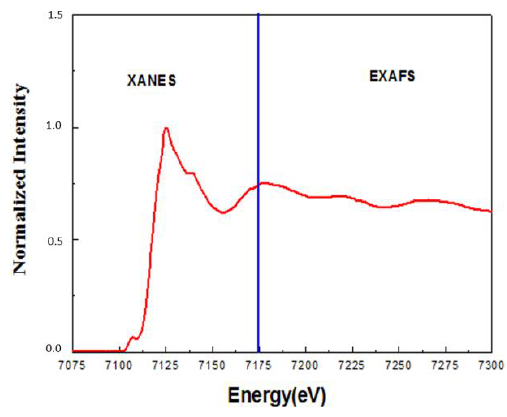
Figure 3. X-ray absorption spectrum of iron oxide nanoparticles (both XANES and EXAFS regions).